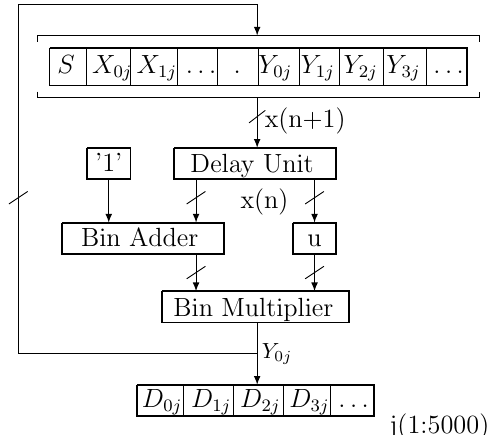
Figure 2. Digital fixed-point implementation of the logistic